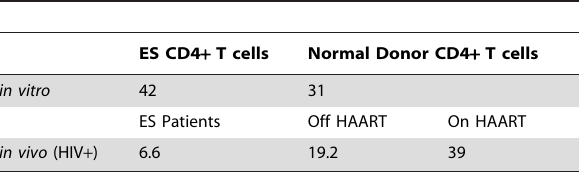
Table 2. Percentage of integrated HIV DNA per reverse